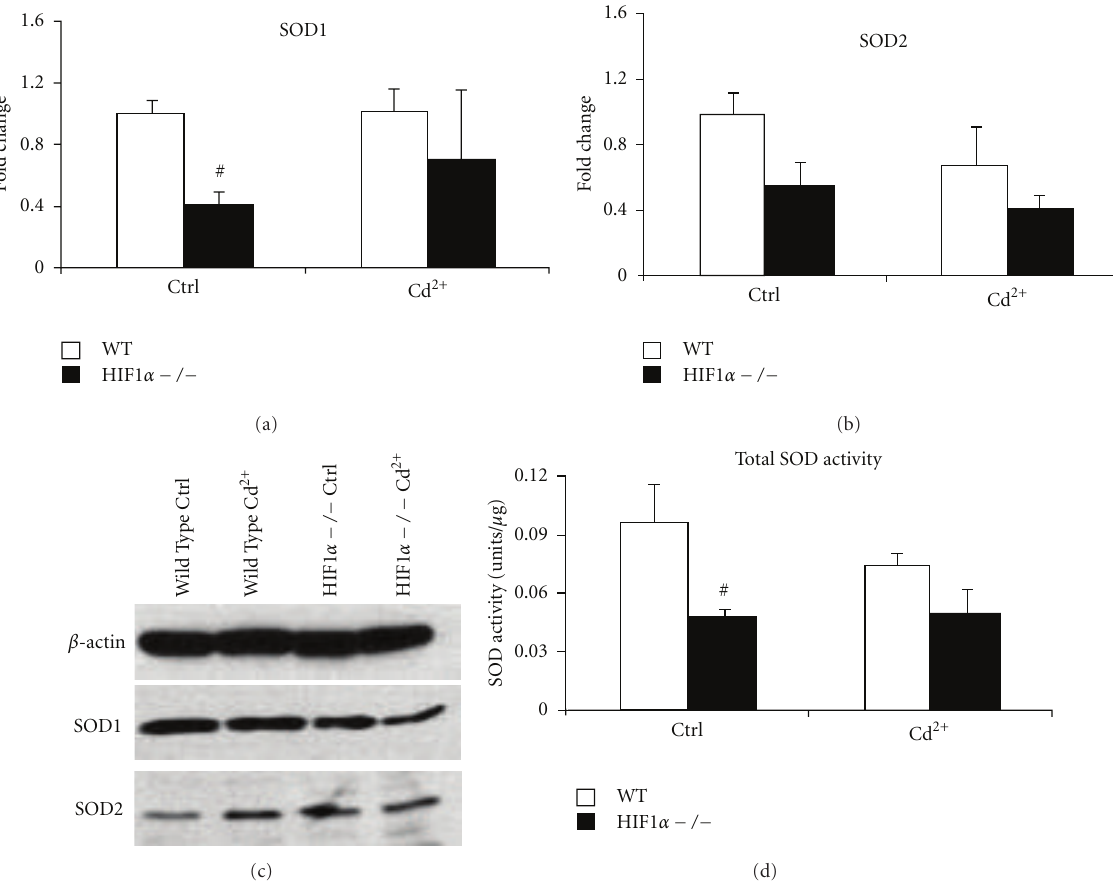
Figure 5: Expression and activity of superoxide dismutases. Transcript levels of SOD1 (a) and SOD2 (b) were determined using qRT-PCR in wild-type (WT, white bars) and HIF1 α − / − cells (black bars). Each value was normalized to the wild-type control levels. Cells were left untreated (Ctrl) or treated with 5 μ M CdCl 2 (Cd 2+ ) for 24 hours. (c) Protein levels of both SOD1 (middle panel) and SOD2 (bottom panel) were determined by Western blotting in wild-type (WT) and HIF1 α − / − cells. β -actin levels (upper panel) were used as a loading control. Cells were treated as in (a) and (b). (d) Total superoxide dismutase enzyme activity in wild-type (WT, white bars) and HIF1 α − / − (black bars) cells were determined. Cells were treated as in (a) and (b). # significant compared to wild-type cells, P < 0 . 05, n = 4.